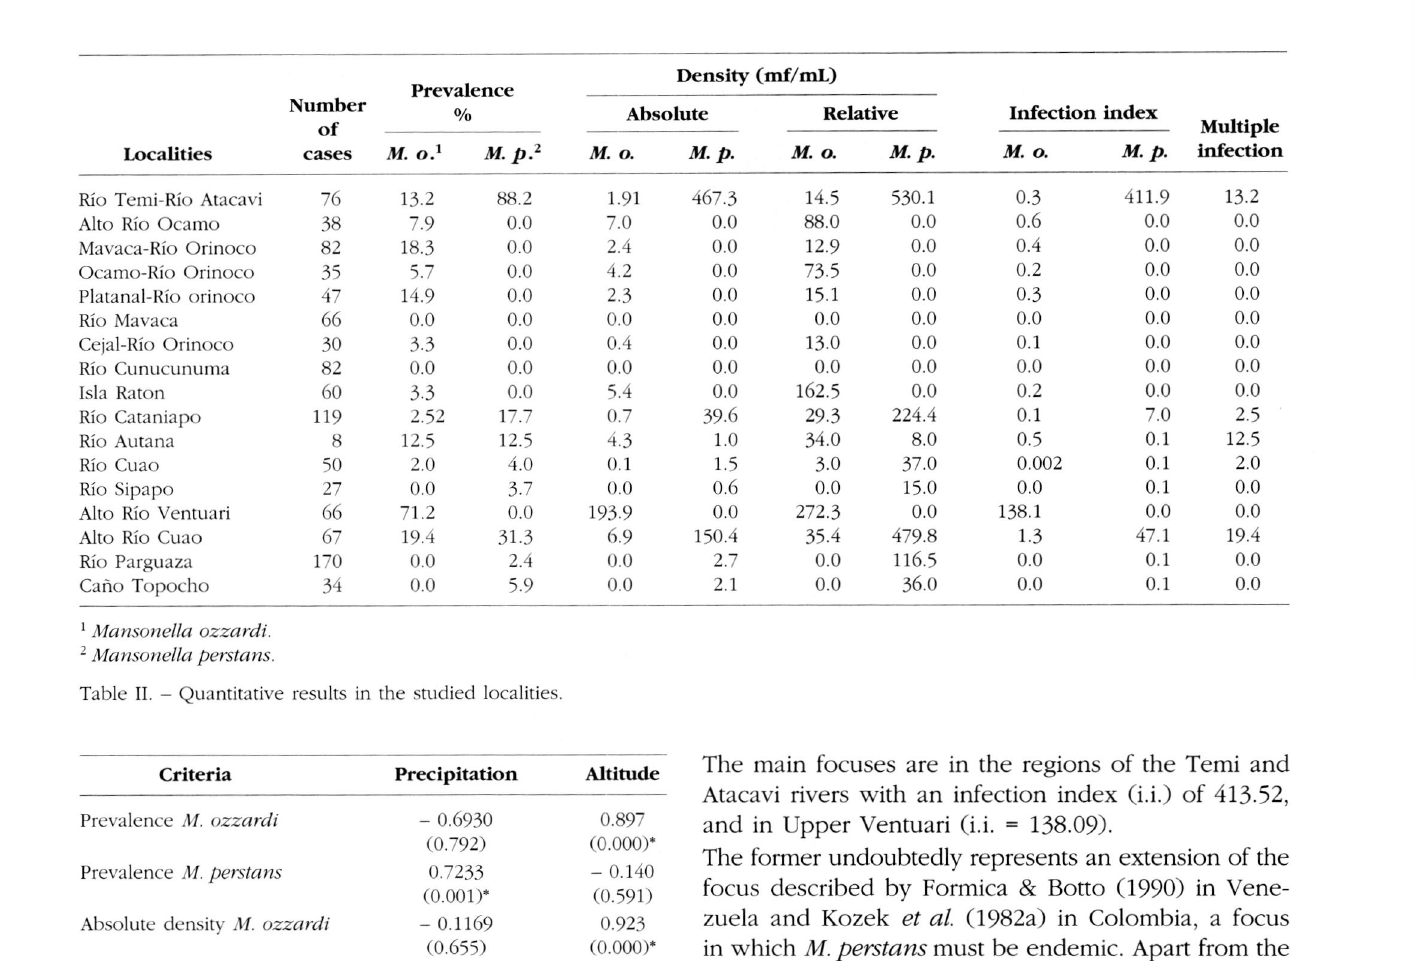
Table II. - Quantitative results in the studied localities.